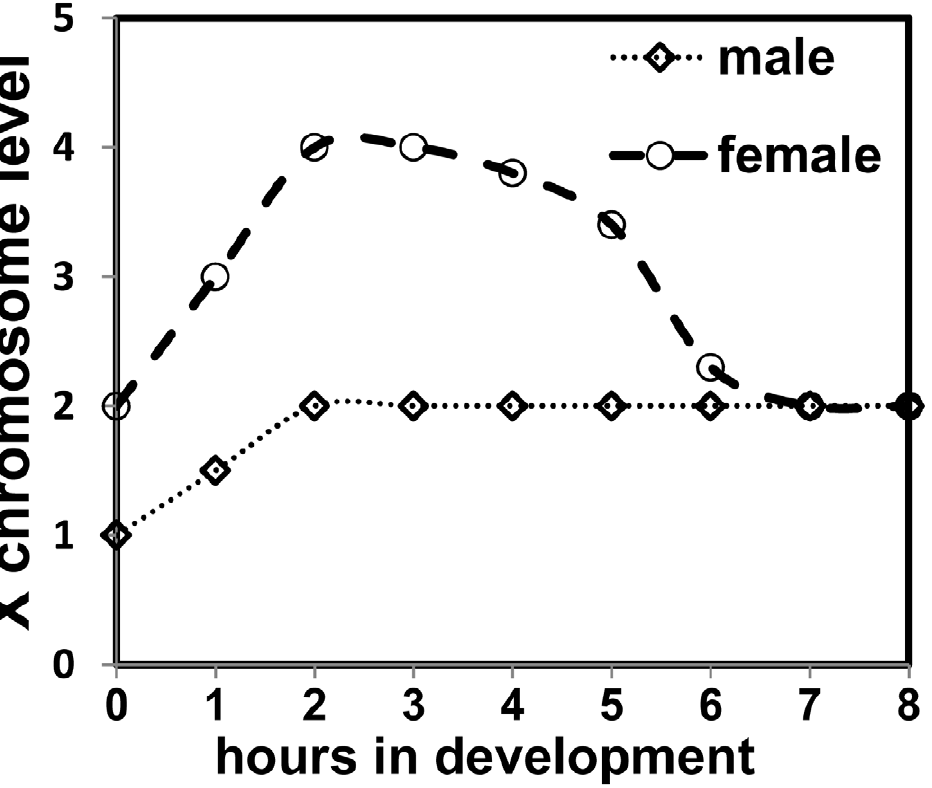
Figure 9. Model depicting X chromosome expression levels in the two sexes. At 25 u C cycle 13 is around 2 h 15 min and cycle 14 concludes around 3 h 15 min. Reduction of the DCC effect is shown as being gradual as the female mode of Sxl splicing is established, and repression of MSL-2 expression is more complete.